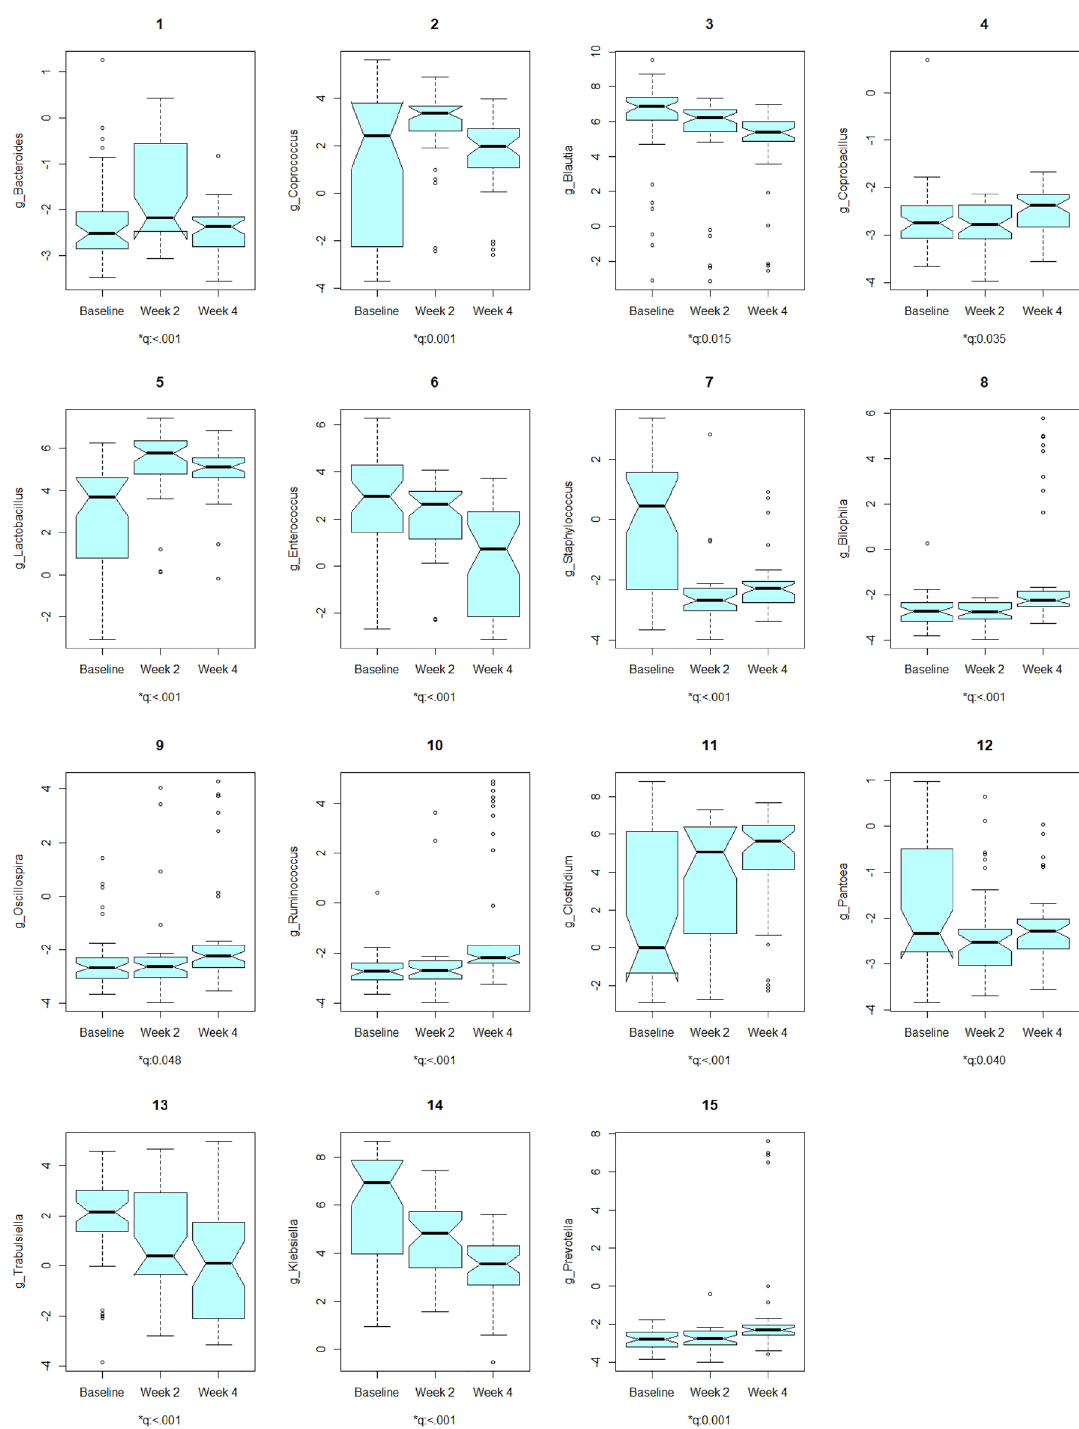
Figure 5. The 15 significant discoveries for comparitive analysis on genera (global test). The Q-values are the FDR adjusted P-values for global testing using LRT based on LMM to see if all groups have the same distribution in each genus ( H 0 ) or if at least one group has a different distribution in each genus index ( H 0